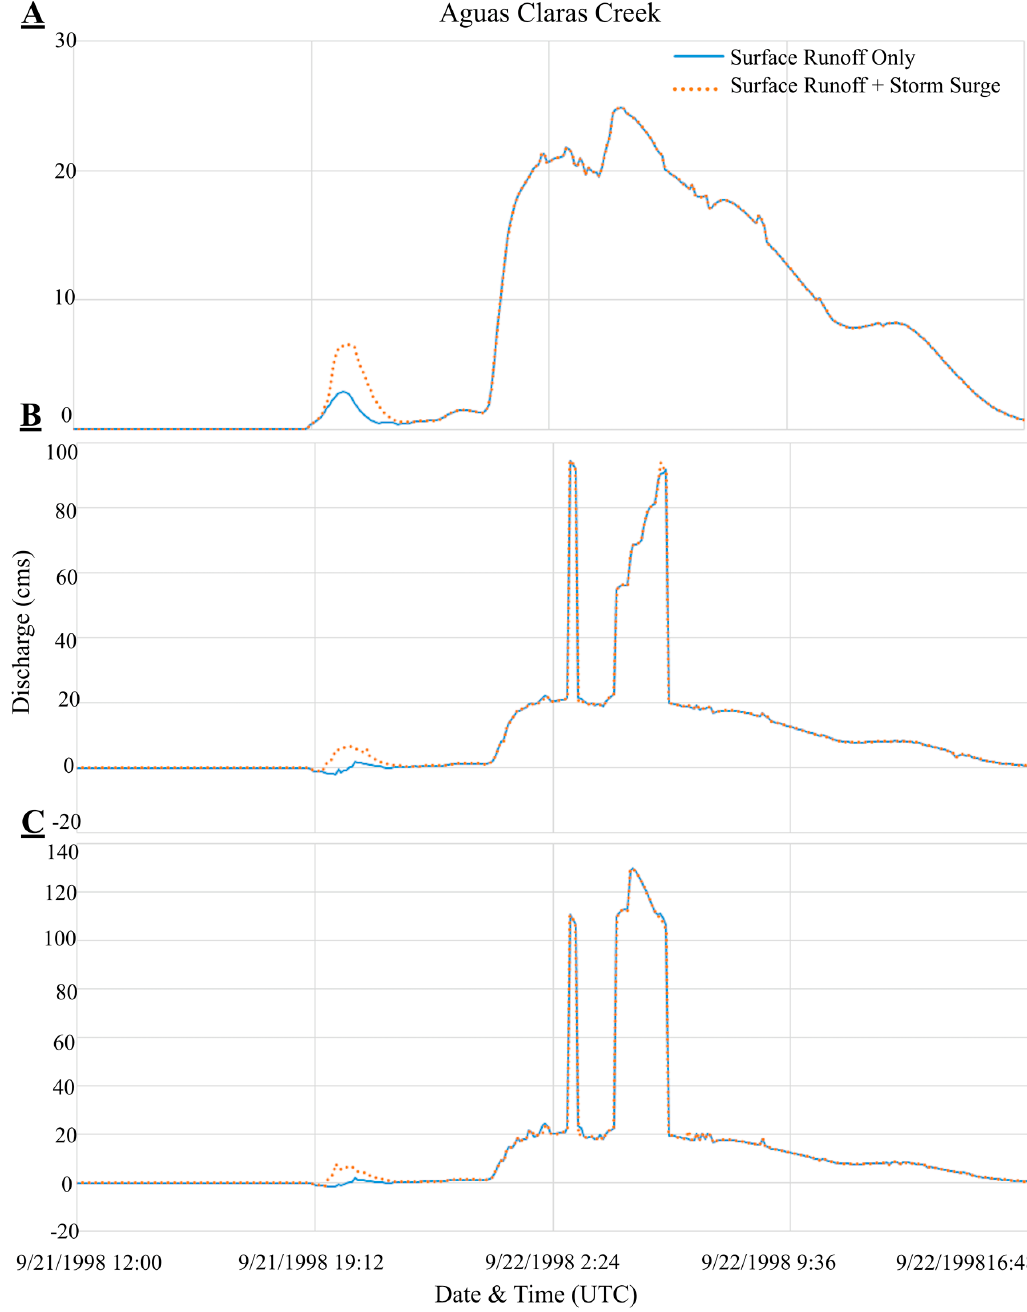
Figure 16. Discharge hydrograph for the different flooding scenario and at different locations for the Aguas Claras Creek watershed. ( A ) At 0-m from the stream outlet; ( B ) At 50-m from the stream outlet; ( C ) At 100-m from the stream outlet. The “Surface Runoff + Storm Surge” flooding scenario is represented with orange dots line and the “Surface Runoff Only” flooding scenario is represented with a solid blue line. The discharge is expressed in cubic meters per second (cms).